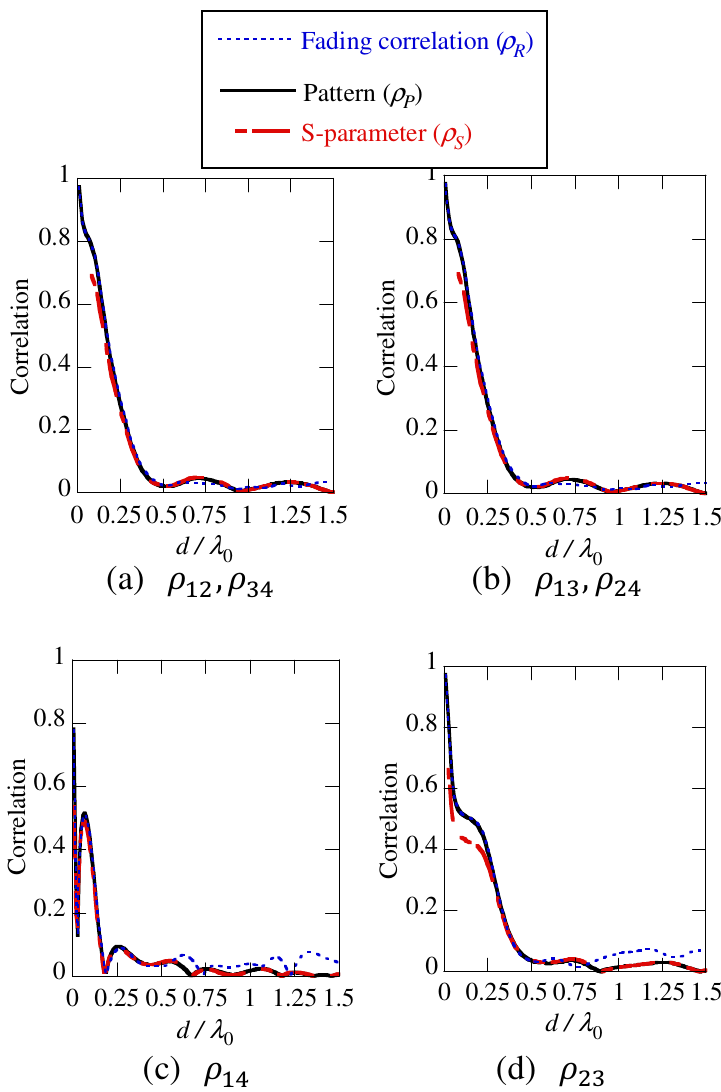
Figure 10. Correlation coefficient versus element spacing d : dipole array( M = 4).